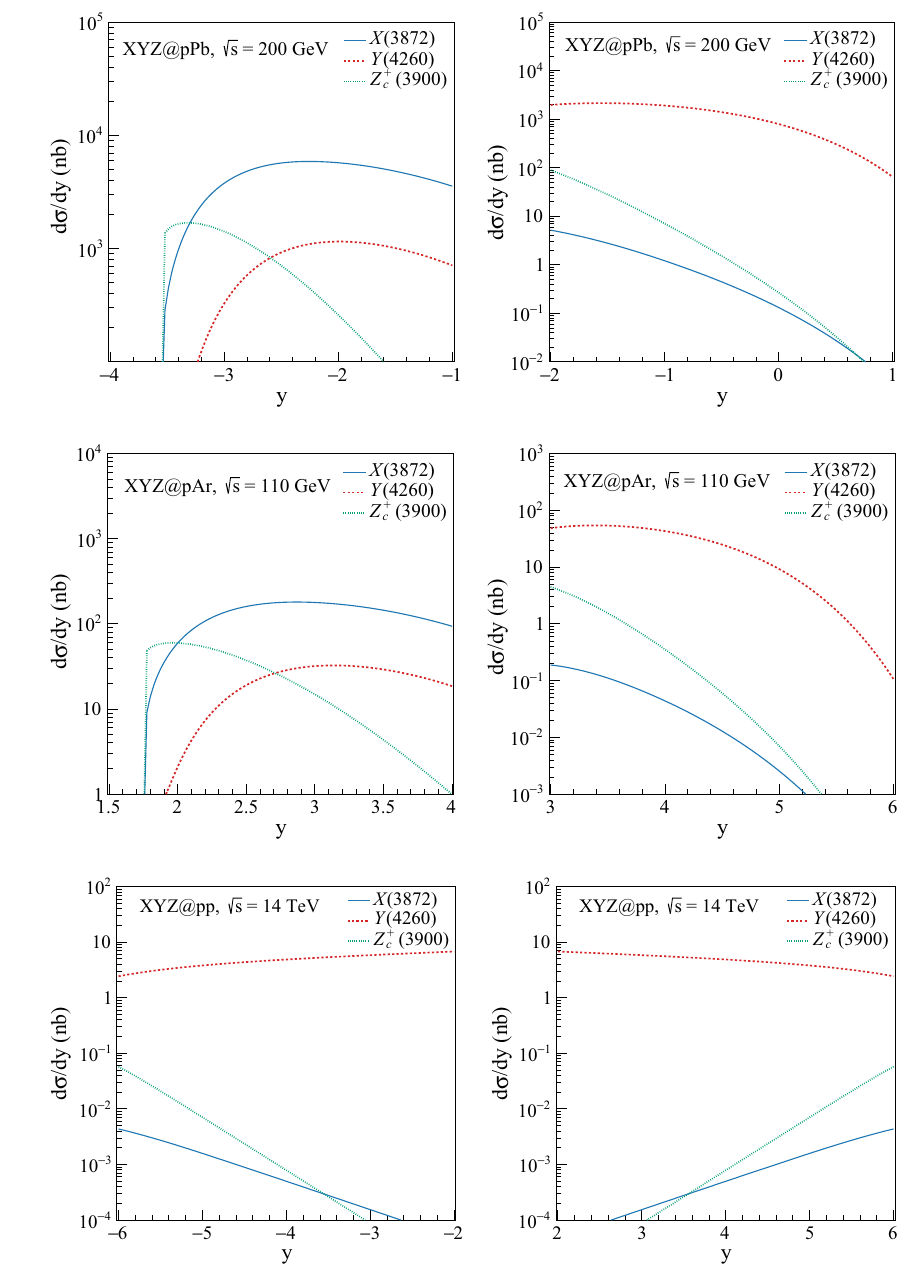
Fig. 1 Rapidity distributions of XY Z particles in pPb UPCs at √ s = 200 GeV at RHIC. The beam of lead is moving in positive rapidity direction. The predictions in moving left panel are calculated in low energy models, while the predictions in the right panel are adopted in high energy models